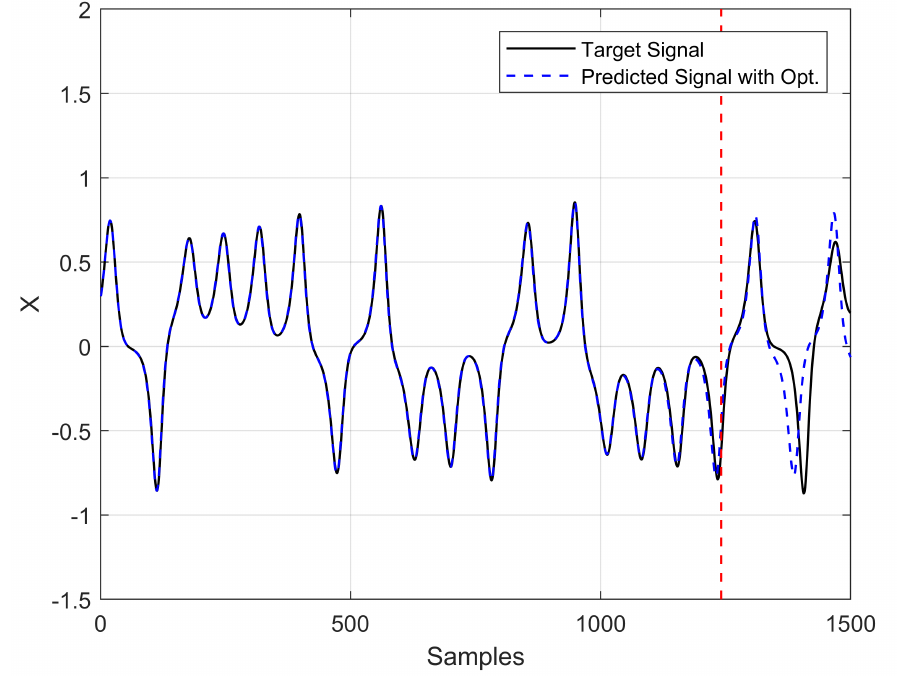
Figure 4. Predicting time series of Lorenz system with an optimized